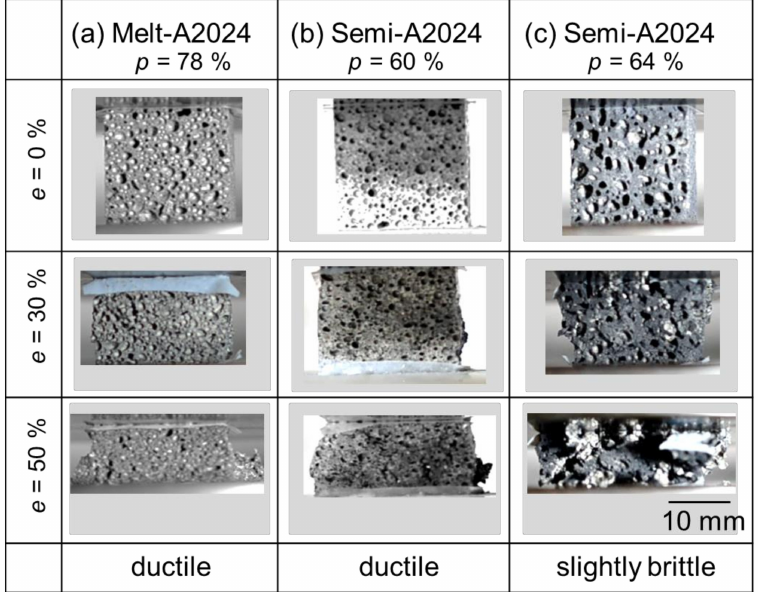
Figure 6. Compressive behavior of the sample during compression